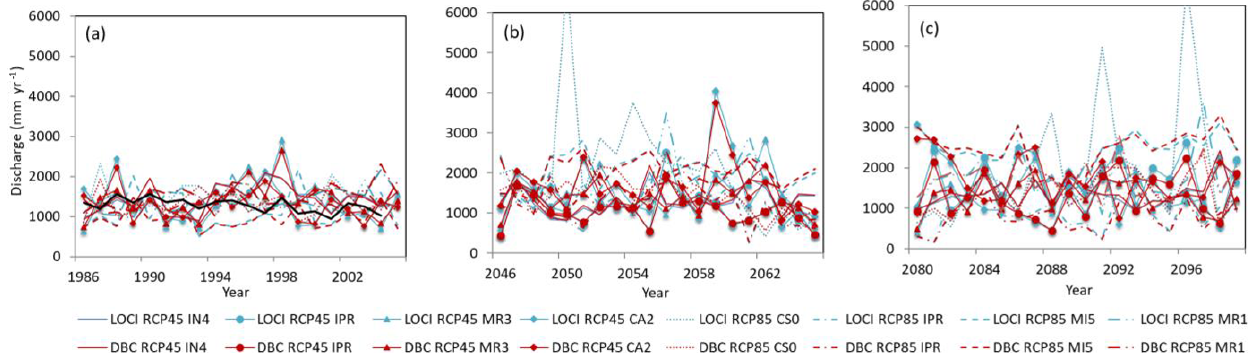
Figure 12. Projected total discharges over the upper Beas basin. Projections are shown for the two bias-correction methods (LOCI and DBC) with two ensembles of four GCMs under RCP4.5 and RCP8.5 (Table 2). (a) Total discharges in the historical period of 1986–2005 from projections and from the corrected gauge precipitation (black line); (b) projected total discharges during 2046–2065; and (c) projected total discharges during